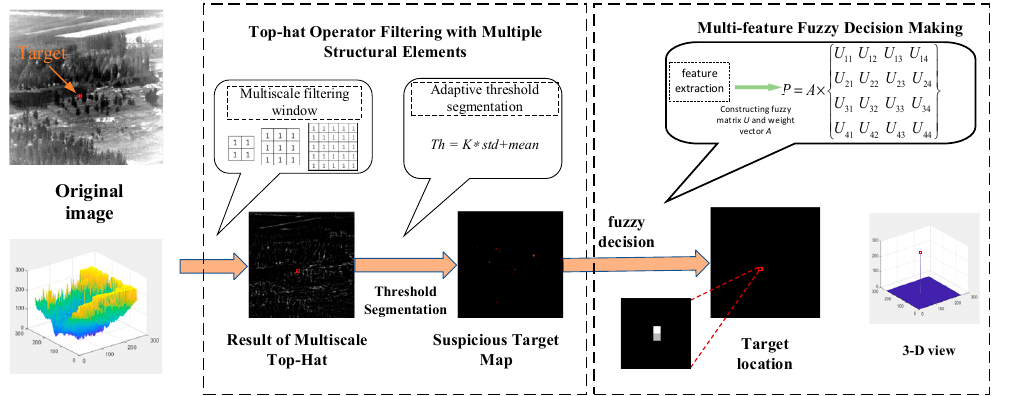
Figure 1. Algorithmic overall structure diagram.